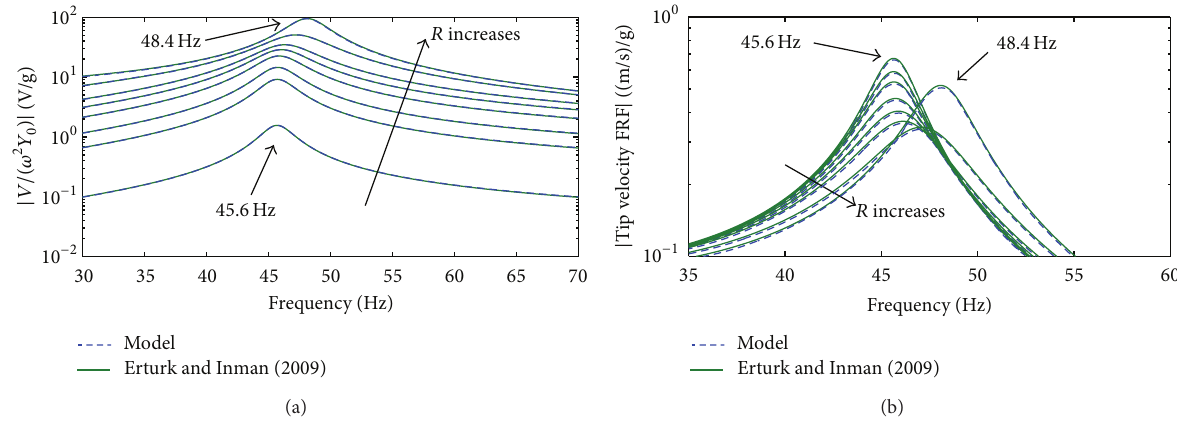
Figure 2: Voltage FRF (a) and tip velocity (FRF) (b) for eight values of load resistance. Table 2: Geometric and material properties of the tapered bimorph